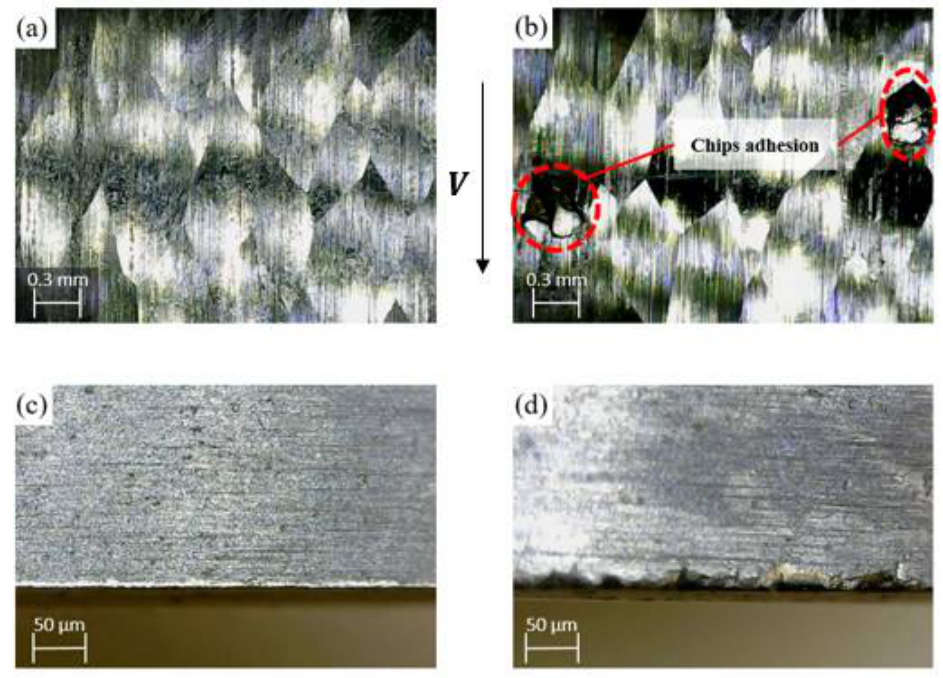
Figure 6. A Comparison between the finished surface and corresponding tool damage based on the inclination angle; ( a ), and ( c ) at 20° and ( b ), and ( d ) at 5°.